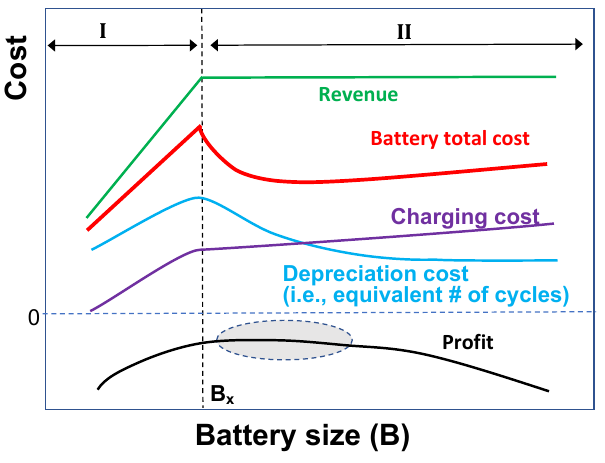
Figure 1. Motivational